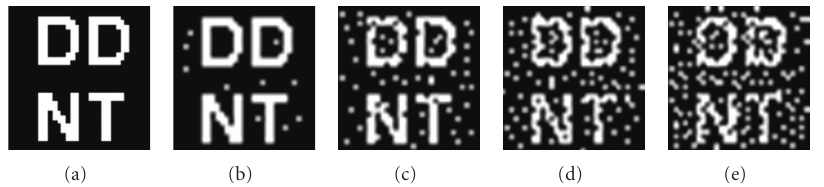
Figure 3: Various examples of extracted watermarks: (a) original watermark, the extracted watermark with error ratio of (b) 1.5%, (c) 5.6%, (d) 10.7%, and (e) 14.2%.